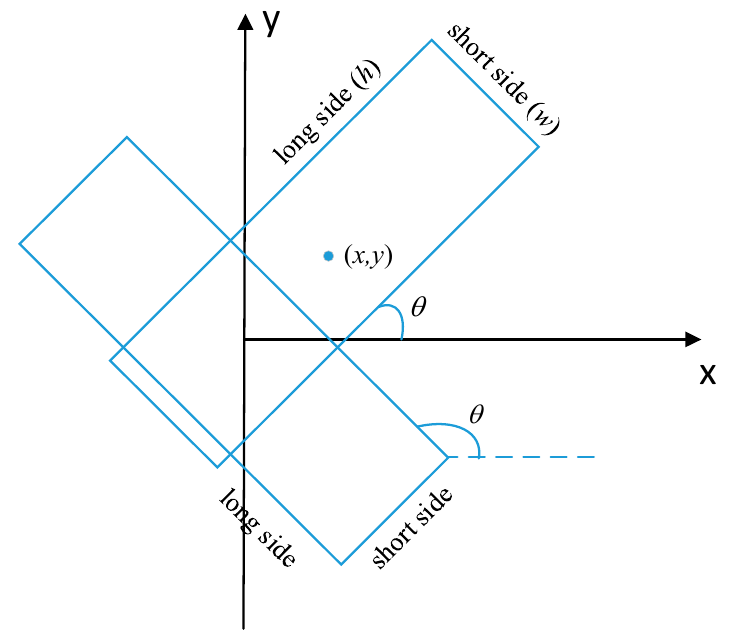
Figure 3. Angle parameter θ of rotation bounding box.